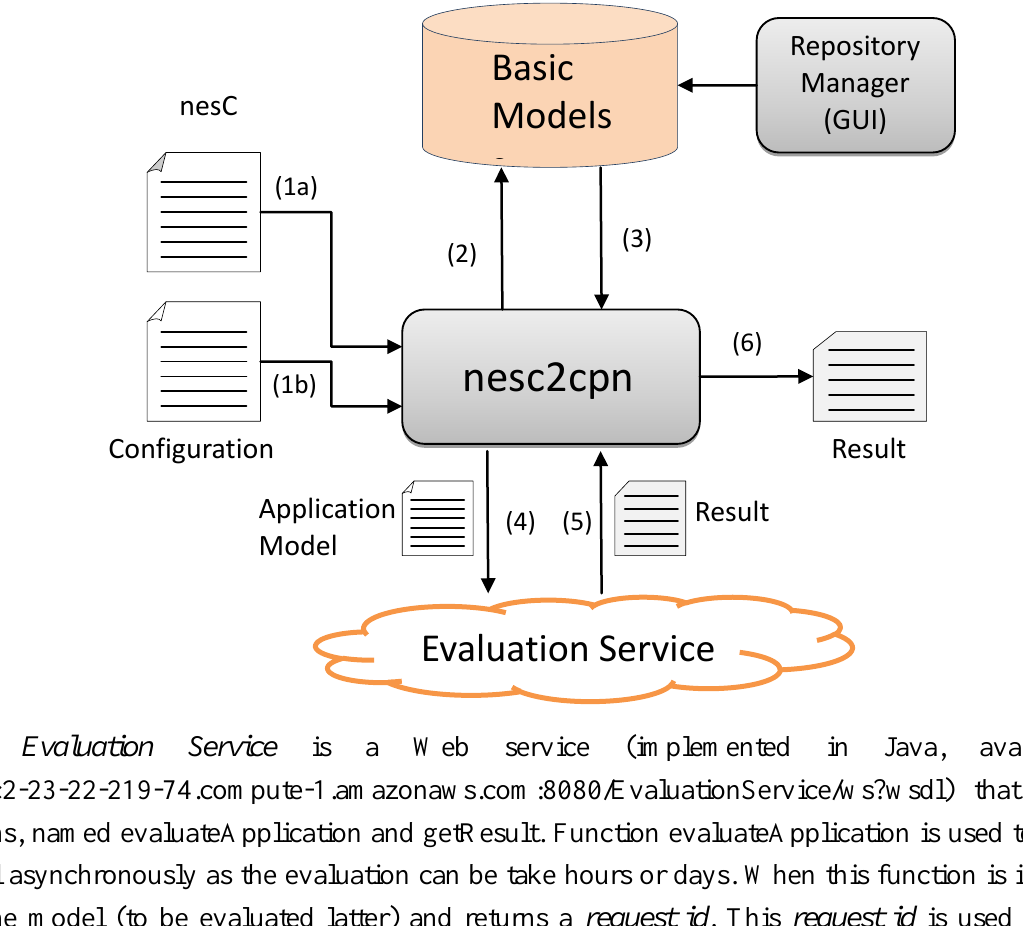
Figure 12. Overview of nesc2cpn